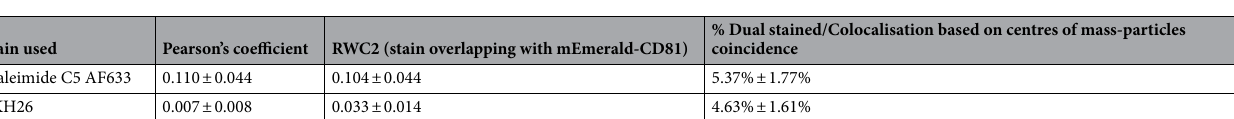
Figure 3. A low percentage of mEmerald-CD81 EVs are dual stained with Maleimide or PKH26. Confocal images of mEmerald-CD81 MCF7 EVs, dual stained with Maleimide C5 AF633 ( a ) or PKH26 ( c ), excess dye removed by SEC and then set in 1% agarose. Green (mEmerald), purple (maleimide C5 AF633; ( a ), and red (PKH26; ( b ) channels are shown along with a composite channel. The composite image has an additional zoomed panel. The white arrows indicate particles where there is colocalisation, the white arrows with an asterisk (*) indicate events where the stain and mEmerald are in close proximity. Scale bar is 10 µm. The fluorescent particle counts were analysed and shown as a % of particles showing the amount of dye that is EV associated (Dual) vs free dye (dye only; c ). The proportion of mEmerald-CD81 EVs that were unstained (EV only) or dual stained (Dual; EV associated) with either maleimide or PKH26 ( d ). N = 3 (Biological), error bars ± SEM.